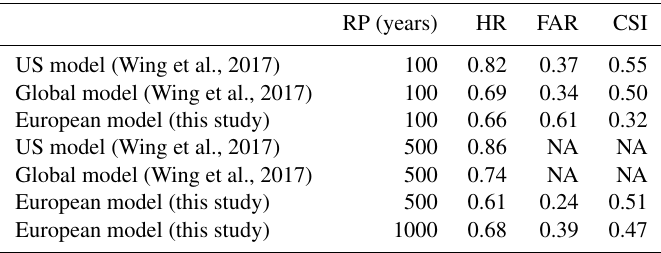
Table 6. Comparison of the performance metrics for the European model described in the present study and the two models evaluated in the study by Wing et al. (2017). NA – not available